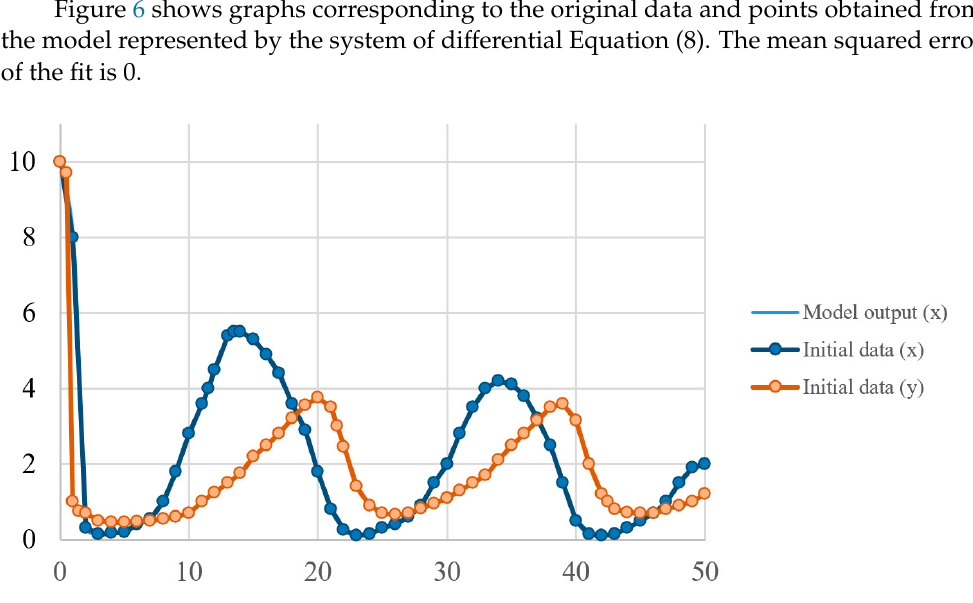
Figure 6. Initial sample fit to the output of the obtained model of changes in the number of predators and prey over time.